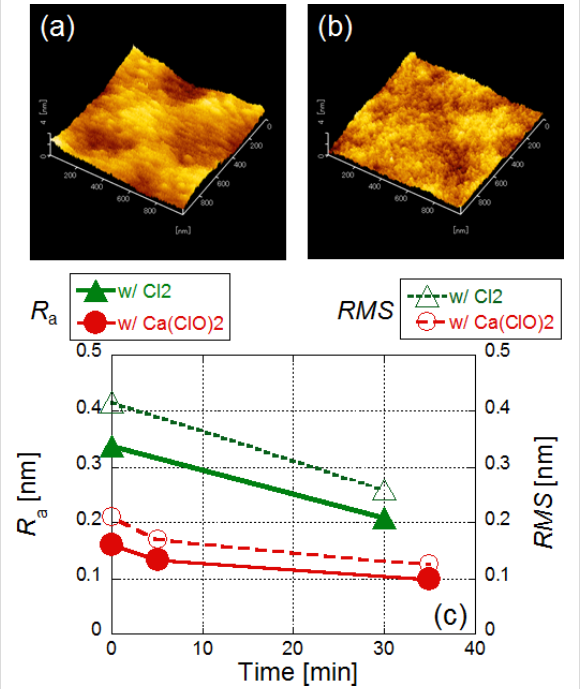
Figure 5: Time dependence of surface roughness. AFM images taken (a) before etching and (b) after 30 min. (c) Time dependence of the value of R a . Red solid circles: with Ca(ClO) 2 , green solid triangles: with Cl 2 . Time dependence of the value of RMS. Red open circles: with Ca(ClO) 2 , green open triangles: with Cl 2